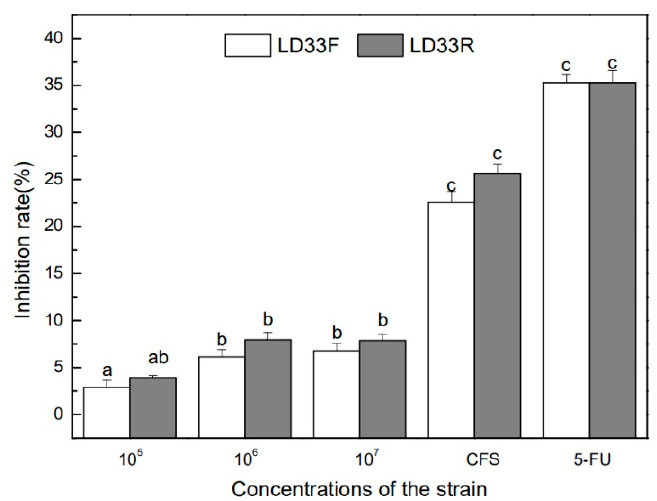
Figure 4. Inhibitory rates to HT-29 cells of E. faecalis LD33 cultured under FC and RPC. The four sample groups were different concentrations (1 × 10 5 , 1 × 10 6 and 1 × 10 7 CFU/mL) of E. faecalis LD33 in HT-29 cells (10 5 cells /mL) suspension and the cell-free supernatant (CFS) of the strain. 5-FU (7 µ g/mL) was used as a positive control. LD33F and LD33R mean E. faecalis LD33 cultured under respiration-permissive and fermentation conditions, respectively. Different letters indicate significant differences ( p < 0.05).